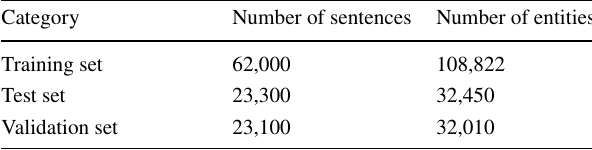
Table 5 Statistics of data set